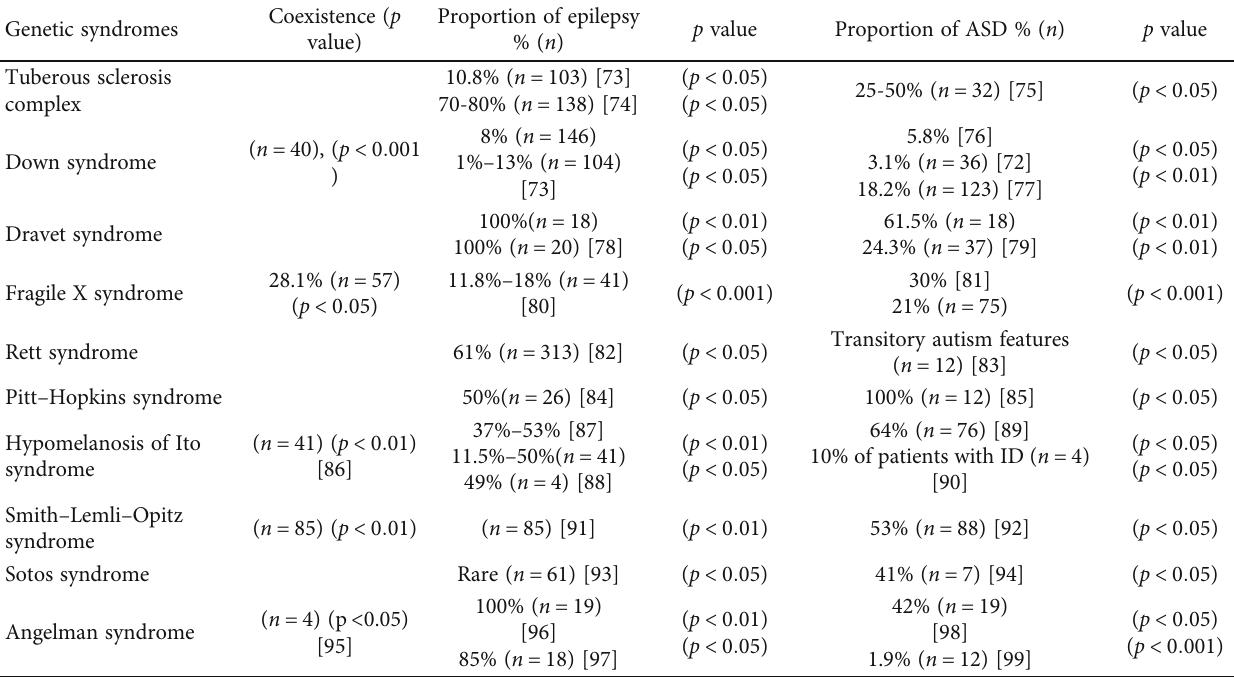
Table 1: Correlating genetic disorder in both epilepsy and